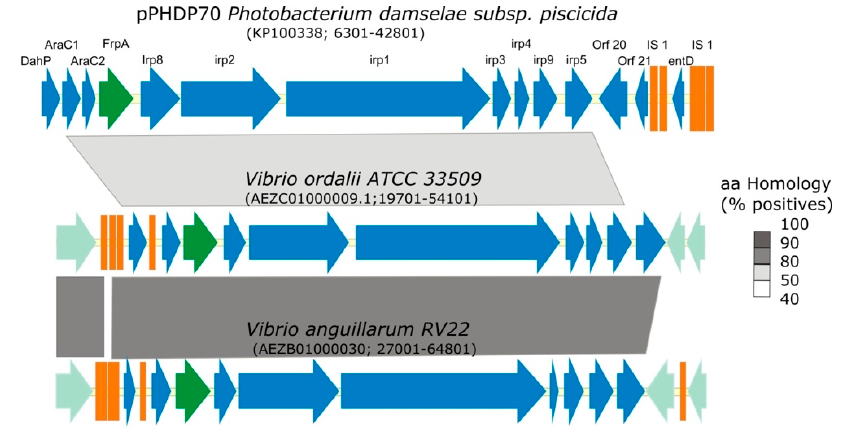
Figure 1. Comparative analysis of the Vibrio ordalii ATCC 33509 T irp gene cluster with the homologous chromosomal region of V. anguillarum RV22 and with the homologous sequence from plasmid pPHDP70 from P. damselae subsp. piscicida . Biosynthetic and regulatory genes are depicted in blue and the gene encoding the outer membrane receptor (FrpA) in green. Other genes and short ORFs are shown in clear green and orange colors. Grey blocks indicate percentages of similarity in the proteins sequence. The GenBank accession numbers and the nucleotide positions interval are indicated below the name of each species.